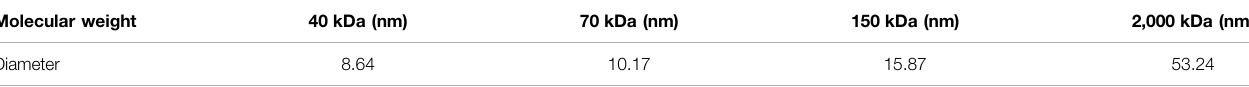
TABLE 1 | Molecular weight corresponding to diameter of nanoparticles. Molecular